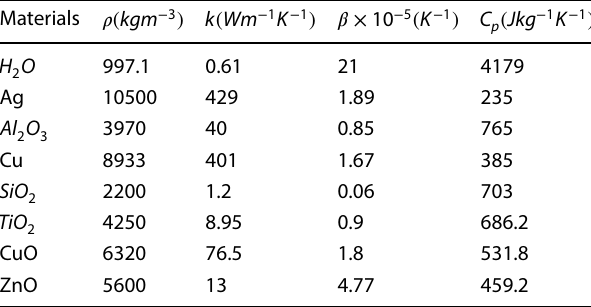
Table 1 Properties for water and nanoparticles [34, 39]